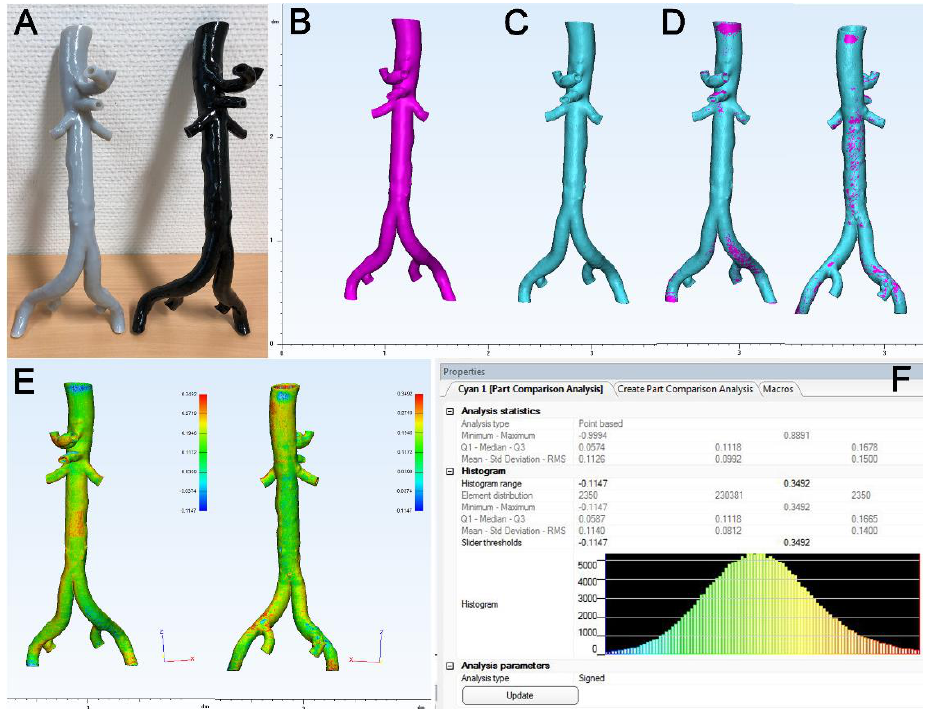
Figure 4. Analysis of surface congruency of 3D model STL versus source STL. ( A ): Two representative models of abdominal aorta printed in flexible and rigid polymer. ( B ): The source STL (fuchsia) and ( C ): the STL of the 3D model (cyan) were imported in the 3Matic module of MIS and ( D ): both objects were brought to congruency using semi-automated alignment tools. ( E ): The part comparison analysis tool of the 3Matic shows a color-coded map of the object indicating the surface deviation between both objects in mm. ( F ): Histogram report of the results indicating the mean value of surface